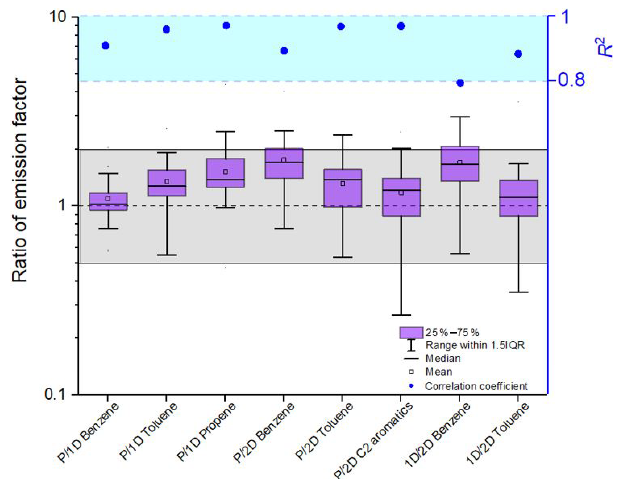
Figure 6. Comparison of PTR-ToF-MS to DC-GC-FID and GC × GC-FID with the black dashed line representing slopes equal to one, grey shaded region representing slopes agreeing within a factor of 2 and shaded blue region indicating correlation coefficients > 0.8; P = PTR-ToF-MS, 1D = DC-GC-FID and 2D = GC × GC-